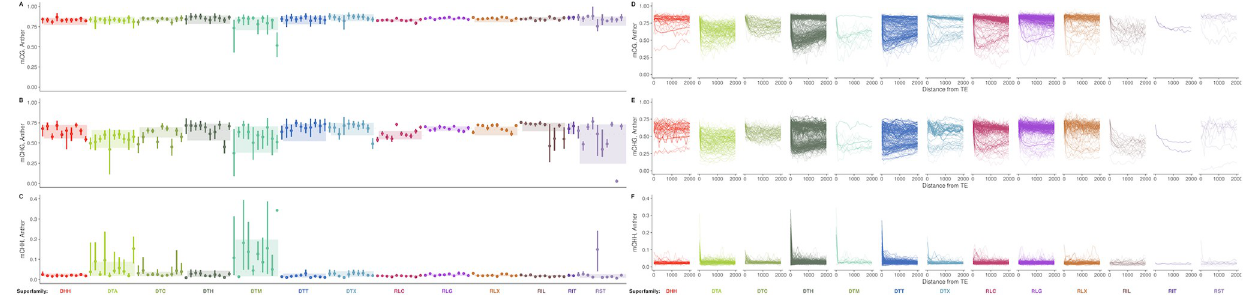
Fig 6. TEs and their flanking sequences are regulated by their host genome. Families are presented in the same order as in Fig 2, and listed in S1 Table. CG methylation in TE (A), CHG methylation in TE (B), and CHH methylation in TE (C). CG methylation in 2 kb flanking the TE (D), CHG methylation in 2 kb flanking the TE (E), and CHH methylation in 2 kb flanking the TE (F). All methylation data from anther tissue, other tissues shown in S8 Fig. In (A —C), superfamily median is shown as a dashed line with the interquartile range in the shaded box. In (D—E), median methylation for regions up to 2 kb up and downstream of the TE are plotted for each family, with family size denoted by line transparency (darker lines are larger